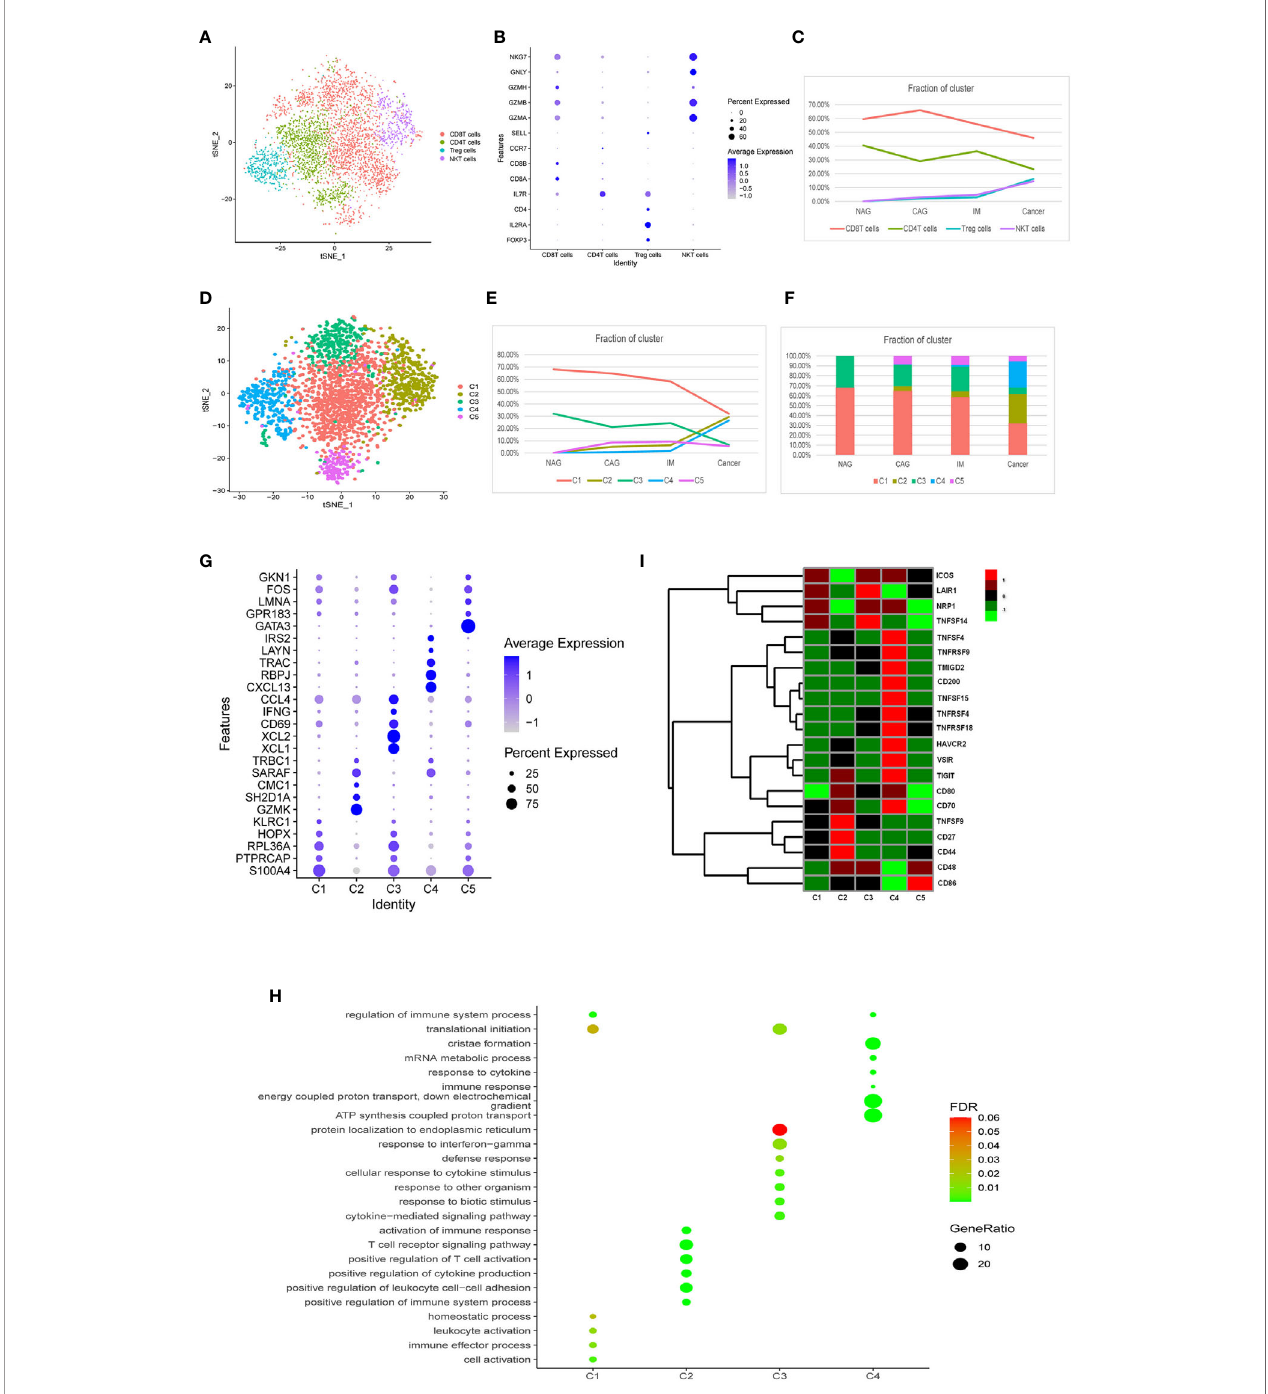
FIGURE 3 | Characterization of multiple changes in T cell subtypes at different stages. (A) tSNE plots of 4,553 T cells, 2,410 CD8 + T cells, 1,213 CD4 + T cells, 478 Treg cells, and 452 NKT cells. Colors indicate cell type. (B) A bubble plot of markers of each cell type; dot sizes represent abundance while the color represents expression levels. (C) Line chart showing changing trend of the proportion of the four cell types across the four stages. (D) A tSNE plot of the fi ve CD8 + T cell subclusters. (E) Stacked histogram showing CD8 + T composition across the four stages. (F) Line chart displaying changing trend of the proportion of the fi ve clusters across the four stages. (G) Bubble plot of top fi ve markers of CD8 + T cell clusters; dot sizes represent abundance while colors represent expression levels. (H) A bubble plot showing the biological functions of different cell clusters using GO. Dot sizes represent abundance while colors represent q values. (I) Heatmap of immune checkpoints altered during the differentiation process of CD8 + T cells, which was clustered into fi ve clusters. A row Z score was used to represent expression